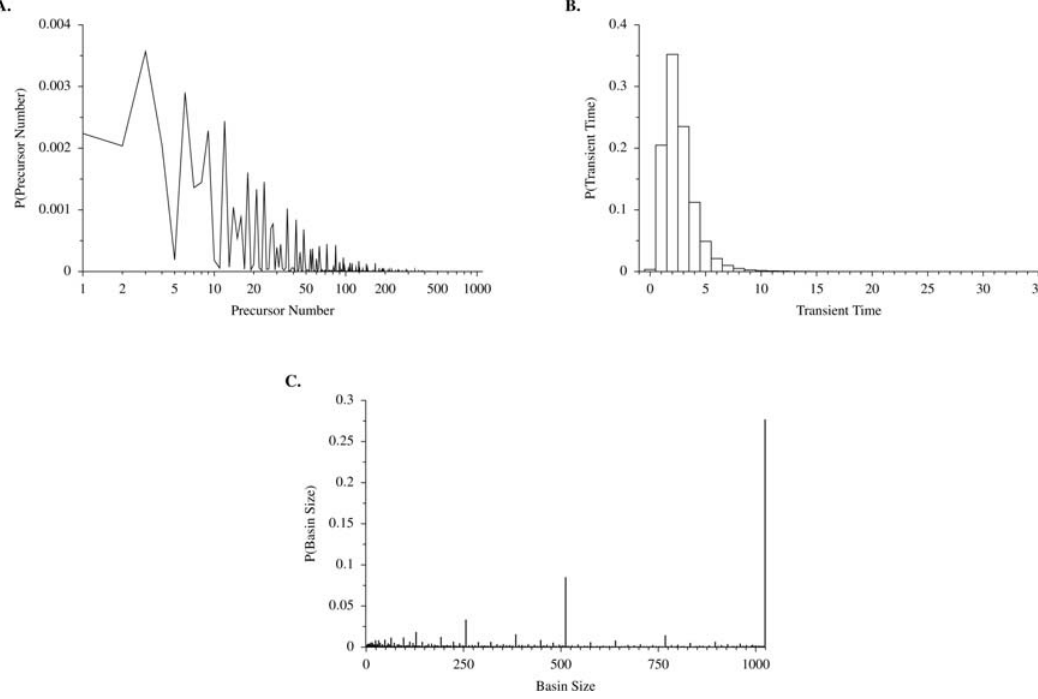
Figure 6. Precursor number, transient time, and basin size for networks of size N =10. (A) Frequency distribution of precursor number across network states, estimated from 40,000 randomly generated networks, on a log scale. Note that P (0) < 0.96 has been suppressed, meaning that the large majority of states have no precursor. (B) Frequency distribution of transient time, estimated from 40,000 randomly generated networks. The maximum value of t is 31 in this number of realizations. (C) Frequency distribution of attractor basin size, defined as the number of states that lead to a given attractor, estimated from 40,000 randomly generated networks of size N =10. Note the peaks at V /2 n , n =0,1,2,…, where V =1024 is the total number of states in each network.